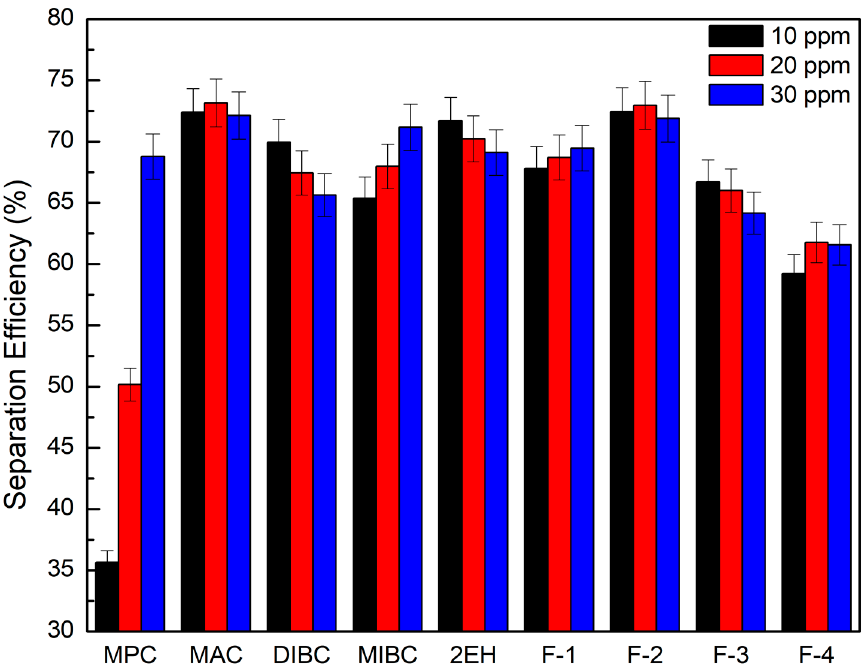
Figure 11. Separation e ffi ciency of evaluated frothers as a function of frother concentration; error bars represent one standard deviation of three replicate tests.